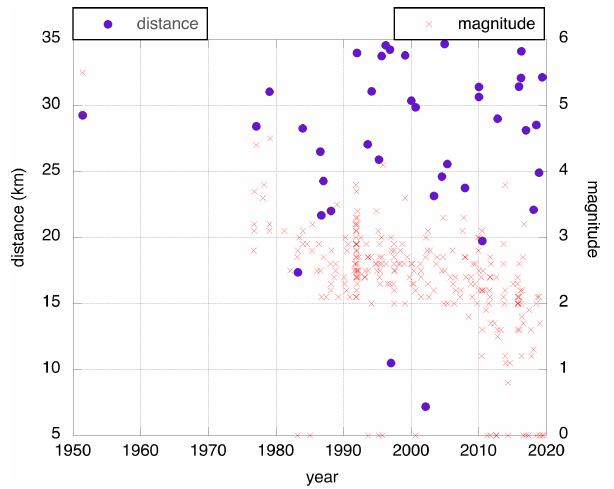
Figure 10. Magnitude–distance plot of relocated events versus time. Blue bullets: hypocentre-to-reservoir distance (only events within 35km distance are shown); red crosses: magnitude. Events with undefined magnitude are represented at magnitude equal to zero (whole